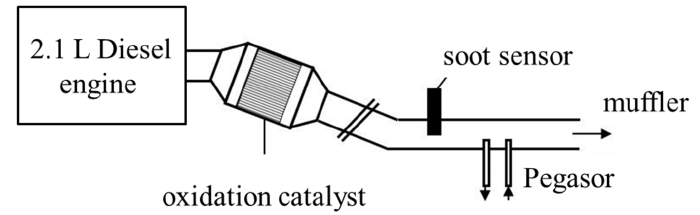
Figure 3. Setup for real exhaust measurements with a 2.1 L diesel engine.